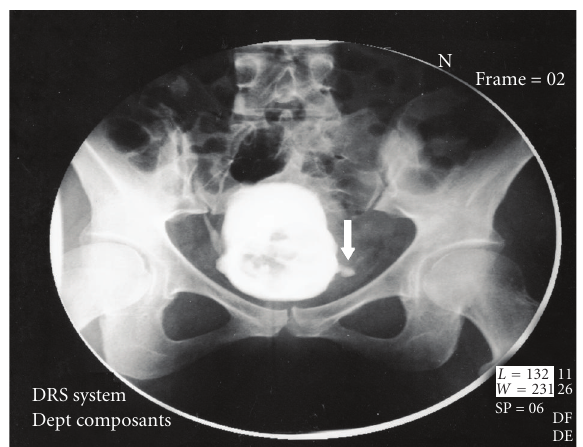
Figure 4: Intraoperative view through a suprapubic cystotomy (arrow).